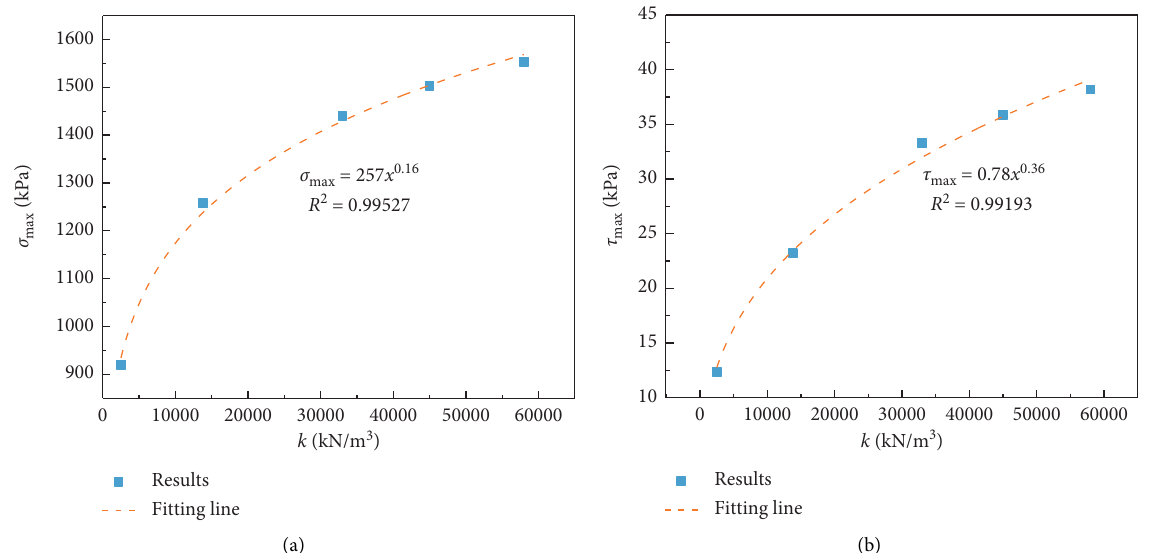
Figure 5: Variation law of maximum normal stress (a) and maximum shear stress (b) of the dangerous section with the changing foundation